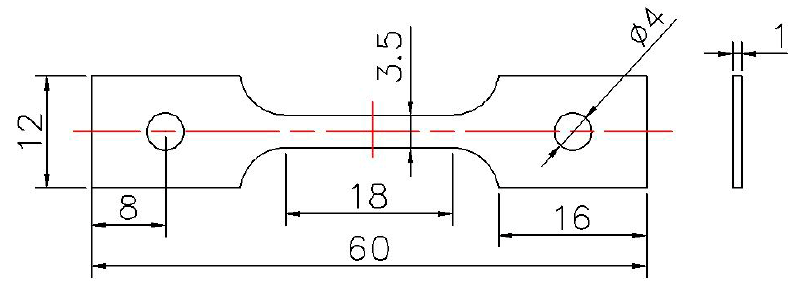
Figure 1. The sketch of samples used in the slow strain rate tensile (SSRT) test (Unit: mm). Table 2. Main experimental parameters during the slow strain rate tensile (SSRT) test.